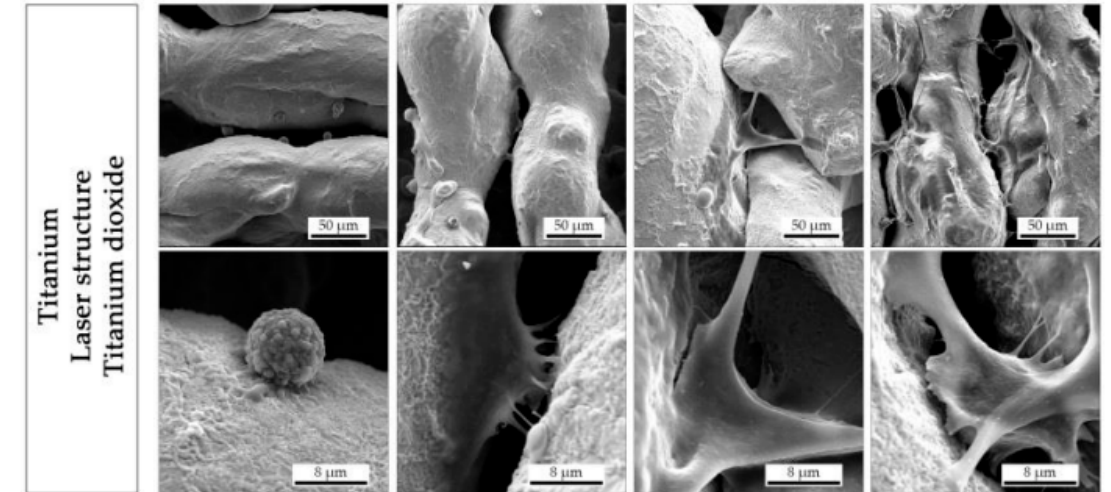
Figure 4. SEM image of human osteoblast-like cells (MG-63), picturing the adhesion on a time of three days at various surface conditions [61].